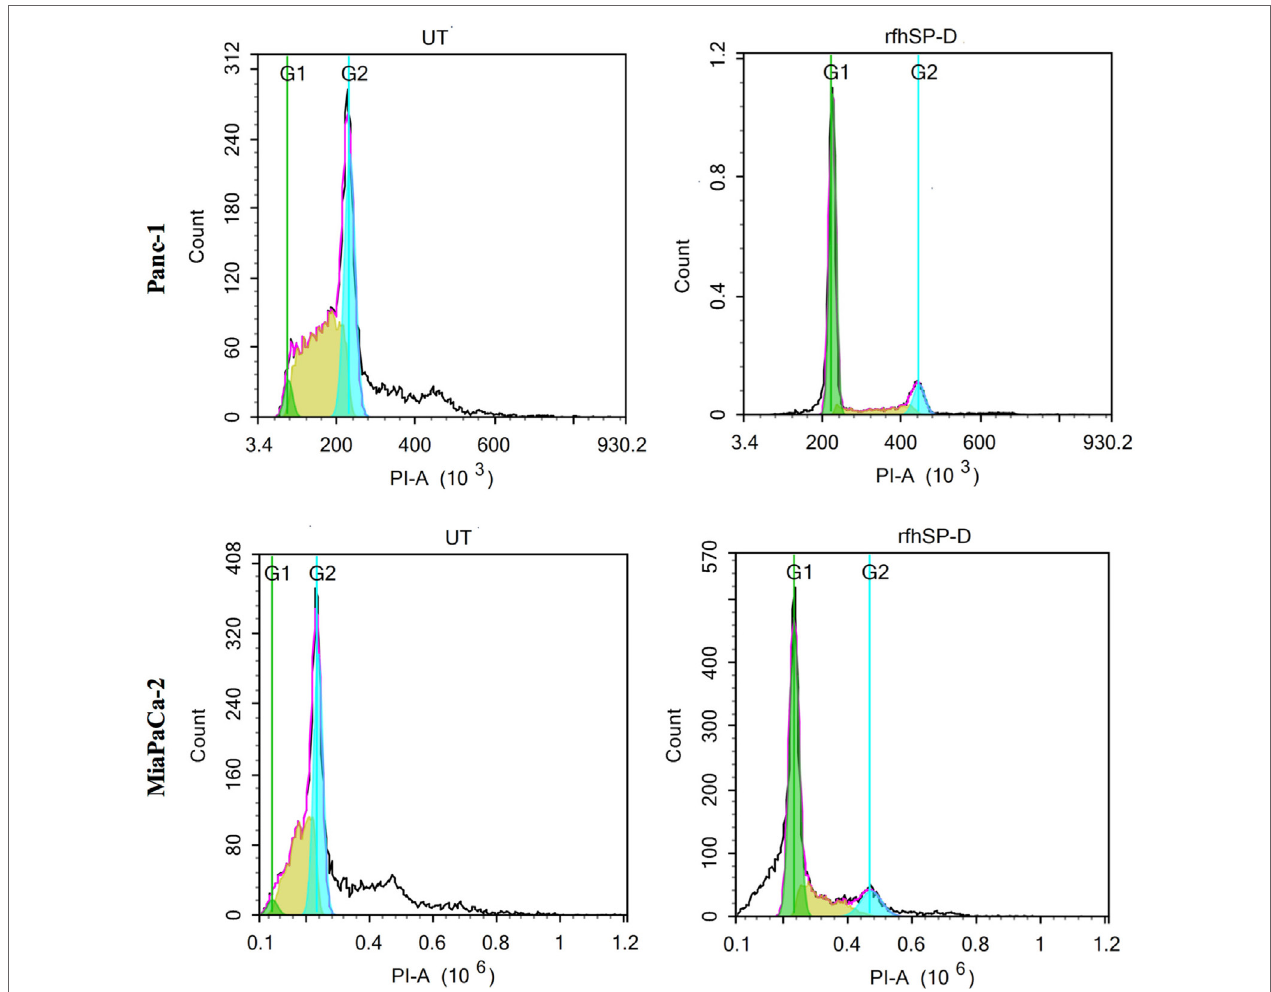
FigUre 2 | Cell cycle analysis following 24 h treatment of pancreatic cancer cell lines with rfhSP-D. Propidium iodide (PI) was used to stain DNA. PI histograms were plotted using set markers within the analysis program of Novocyte Flow cytometer. The rfhSP-D treated pancreatic cancer cells show arrest in G1 phase in the case of Panc-1 (G1 phase: 68%; S phase: 13%; G2 phase: 11%) and MiaPaCa-2 (G1 phase: ~50%; S phase: 17%; G2 phase: 10%) cell line at 24 h, whereas untreated Panc-1 cells (G1 phase: 3%; S phase: 42%; G2 phase: 32%) and MiaPaCa-2 cells (G1 phase: 2%; S phase: 32%; G2 phase: 33%) progressed to the next cell cycle